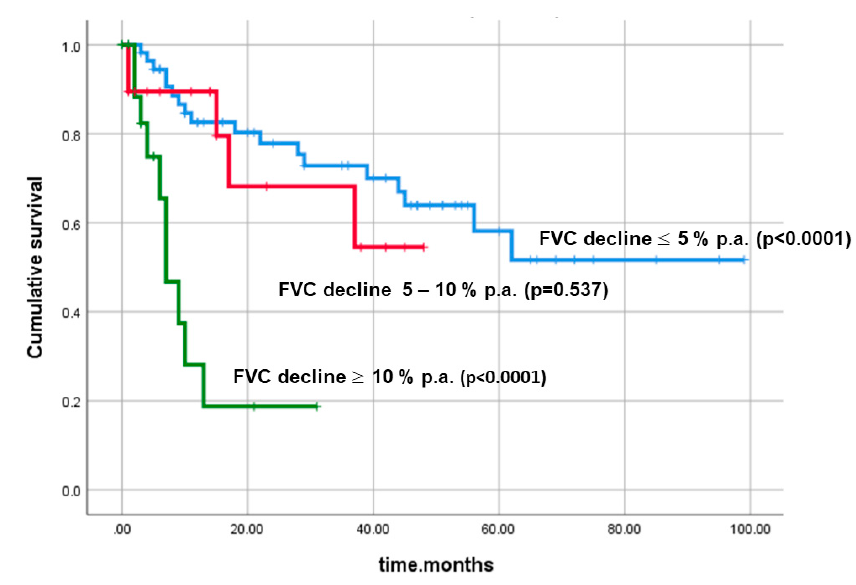
Figure 6. Cumulative survival with regard to forced vital capacity (FVC) decline p.a. ( p < 0.0001). Abbreviations: FVC—forced vital capacity, % pred.—percentage of predicted value.